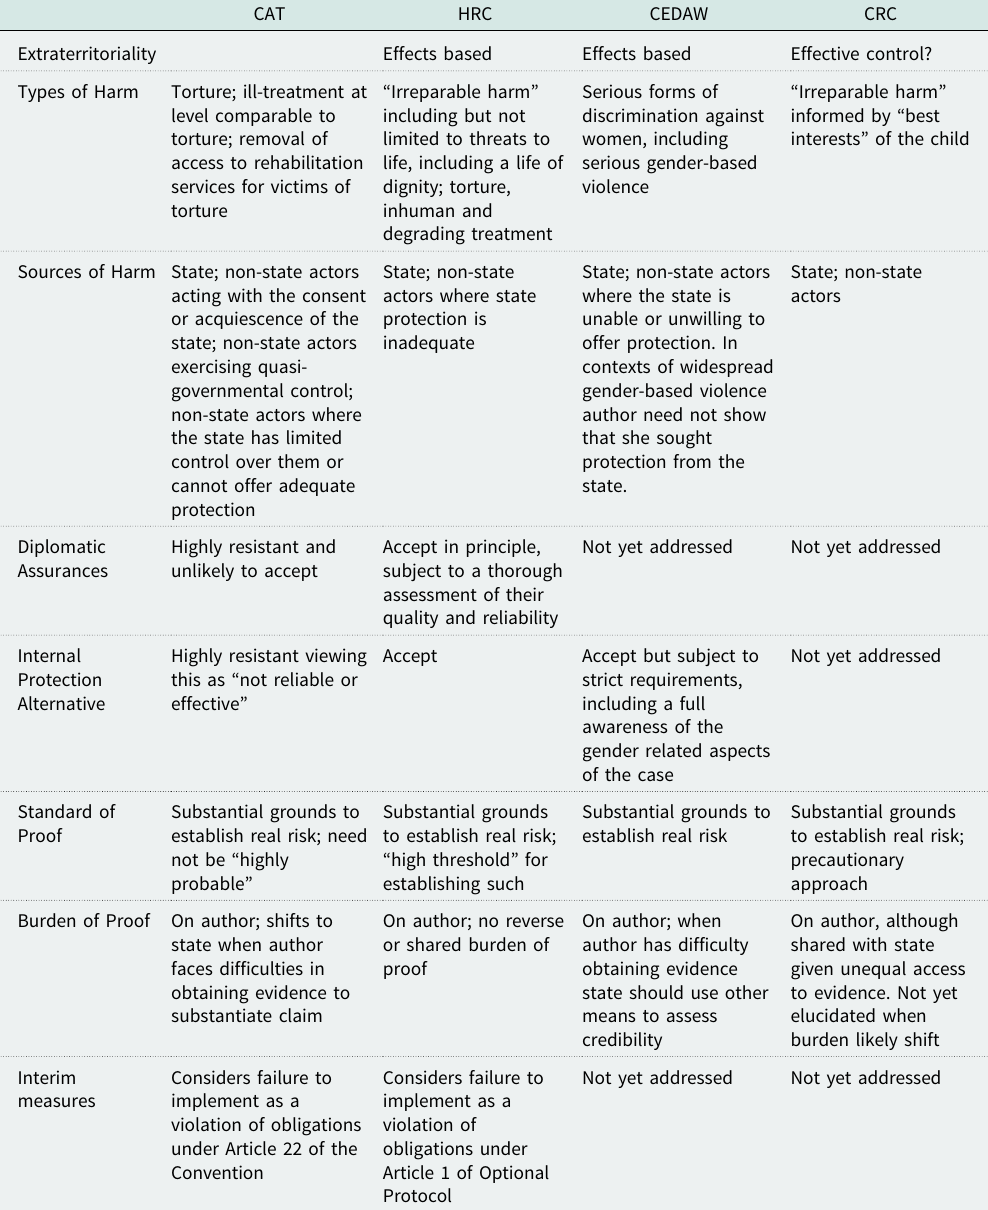
Table 1: Comparison of interpretative approaches to non-refoulement across the four UNTBs CAT HRC CEDAW